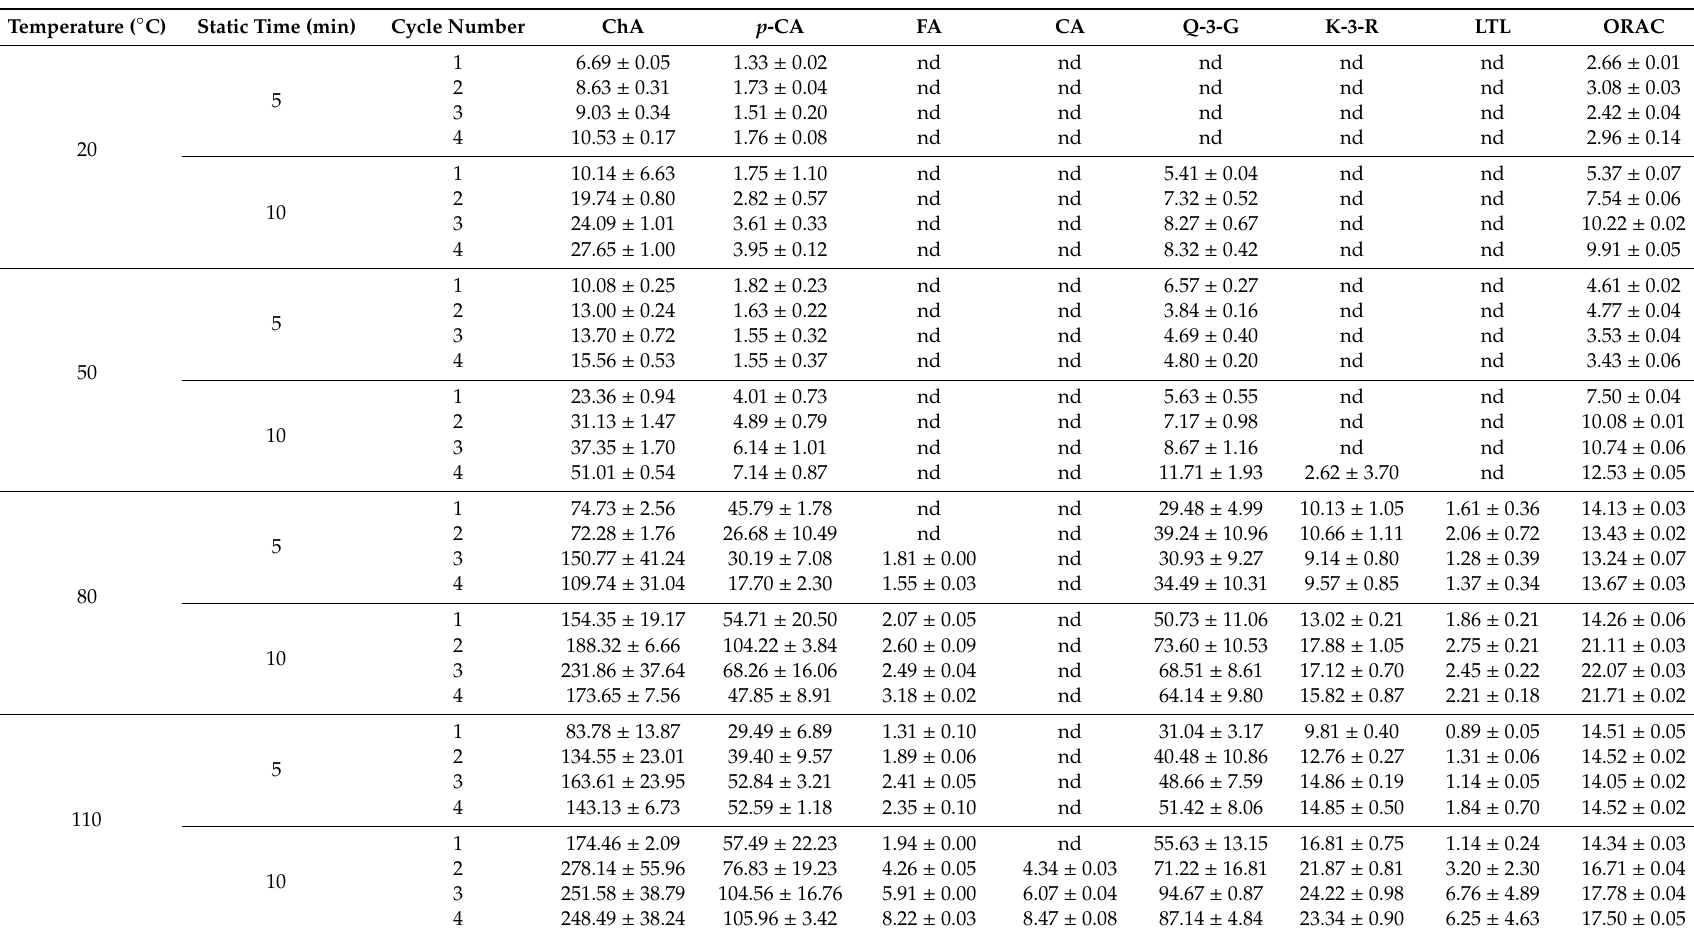
Table 1. Nettle leaves polyphenols (mg 100 g − 1 dm) and ORAC values (mmol TE 100 g − 1 dm) in extracts obtained at ASE di ff erent